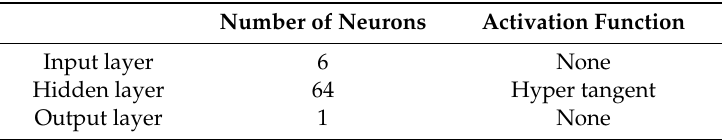
Table 2. Information about ANN structure.